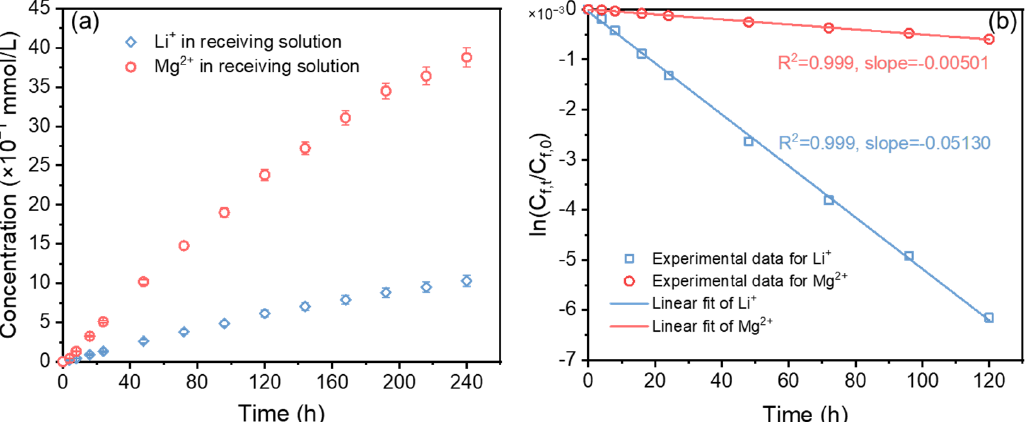
Figure 10. The results of the long-term transport experiment: ( a ) the concentrations of Li + and Mg 2+ in the receiving solution; ( b ) the kinetics plots of ln( C f,t /C f,0 ) vs. time; membrane: CTA/P507-TBP60%; feed solution: 0.1 mol/L of LiCl, 4.0 mol/L of MgCl 2 and 0.13 mol/L of FeCl 3 ; test time: 240 h; n = 5.